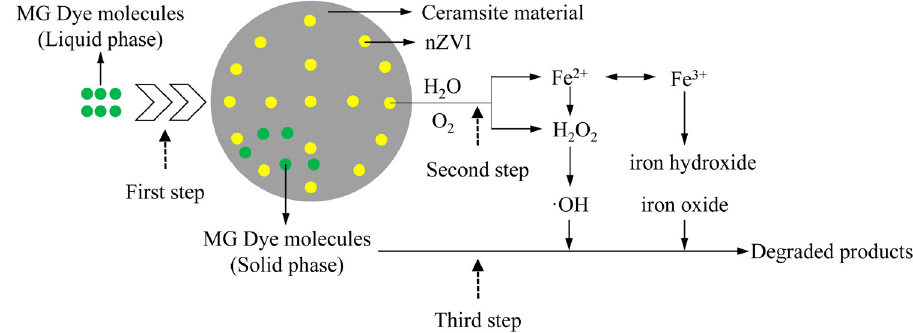
Figure 7: Mechanism diagram of the treatment of MG dye from water using ceramsite - supported nZVI in a fi xed - bed reactor